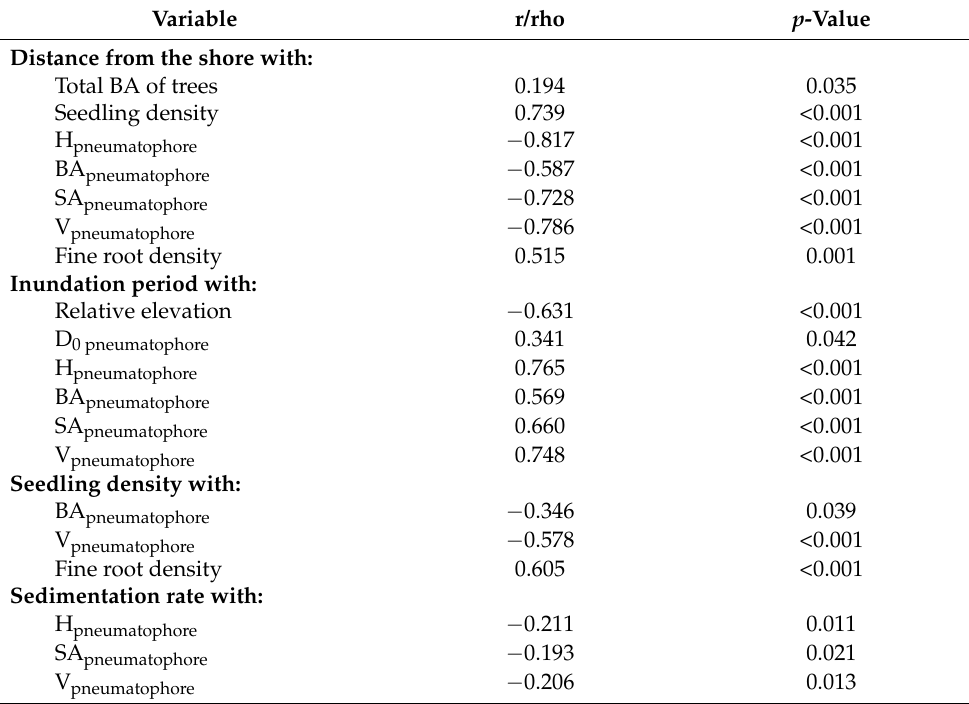
Table 3. Relationships between mangrove vegetation and sediment across the